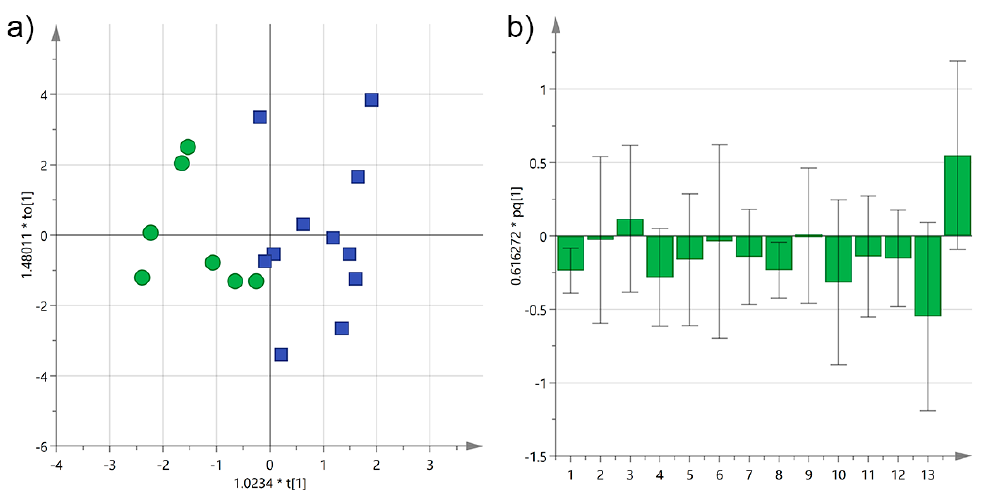
Figure 9. ( a ) OPLS-DA score plot for Cellina EVOO samples from Salento categorized by the age of the olive trees (green circles ≤ 100 years; blue squares > 100 years); ( b ) OPLS-DA loadings column plot for the first predictive component of the model (variables: 1 = total biophenols; 2 = hydroxytyrosol; 3 = tyrosol; 4 = 3,4-DHPEA-EDA; 5 = 3,4-DHPEA-EA; 6 = lignans; 7 = luteolin; 8 = p -HPEA-EDA; 9 = p -HPEA-EA; 10 = 3,4-DHPEA-EA in the mixed aldehydic and hydroxylic form; 11 = p -HPEA-EA in the mixed aldehydic and hydroxylic form; 12 = α -tocopherol; 13 ≤ 100 years; 14 > 100 years).